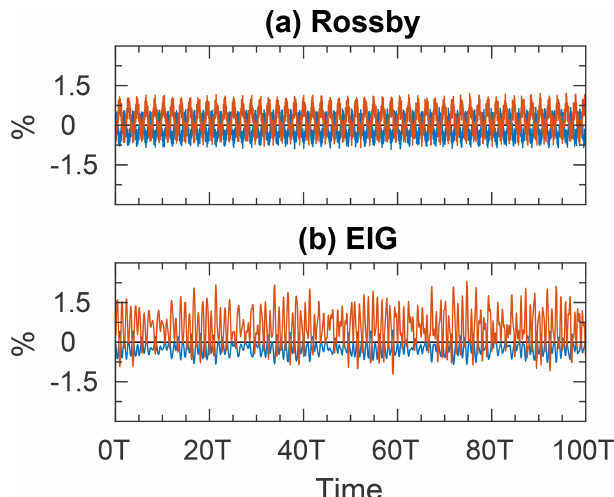
Figure 6. The structure error defined in Eq. (8) for both the Rossby (a) and EIG (b) waves as a function of time. Blue: cal- culated for the velocity vector u = (u,v) . Red: calculated for the geopotential (cid:56)